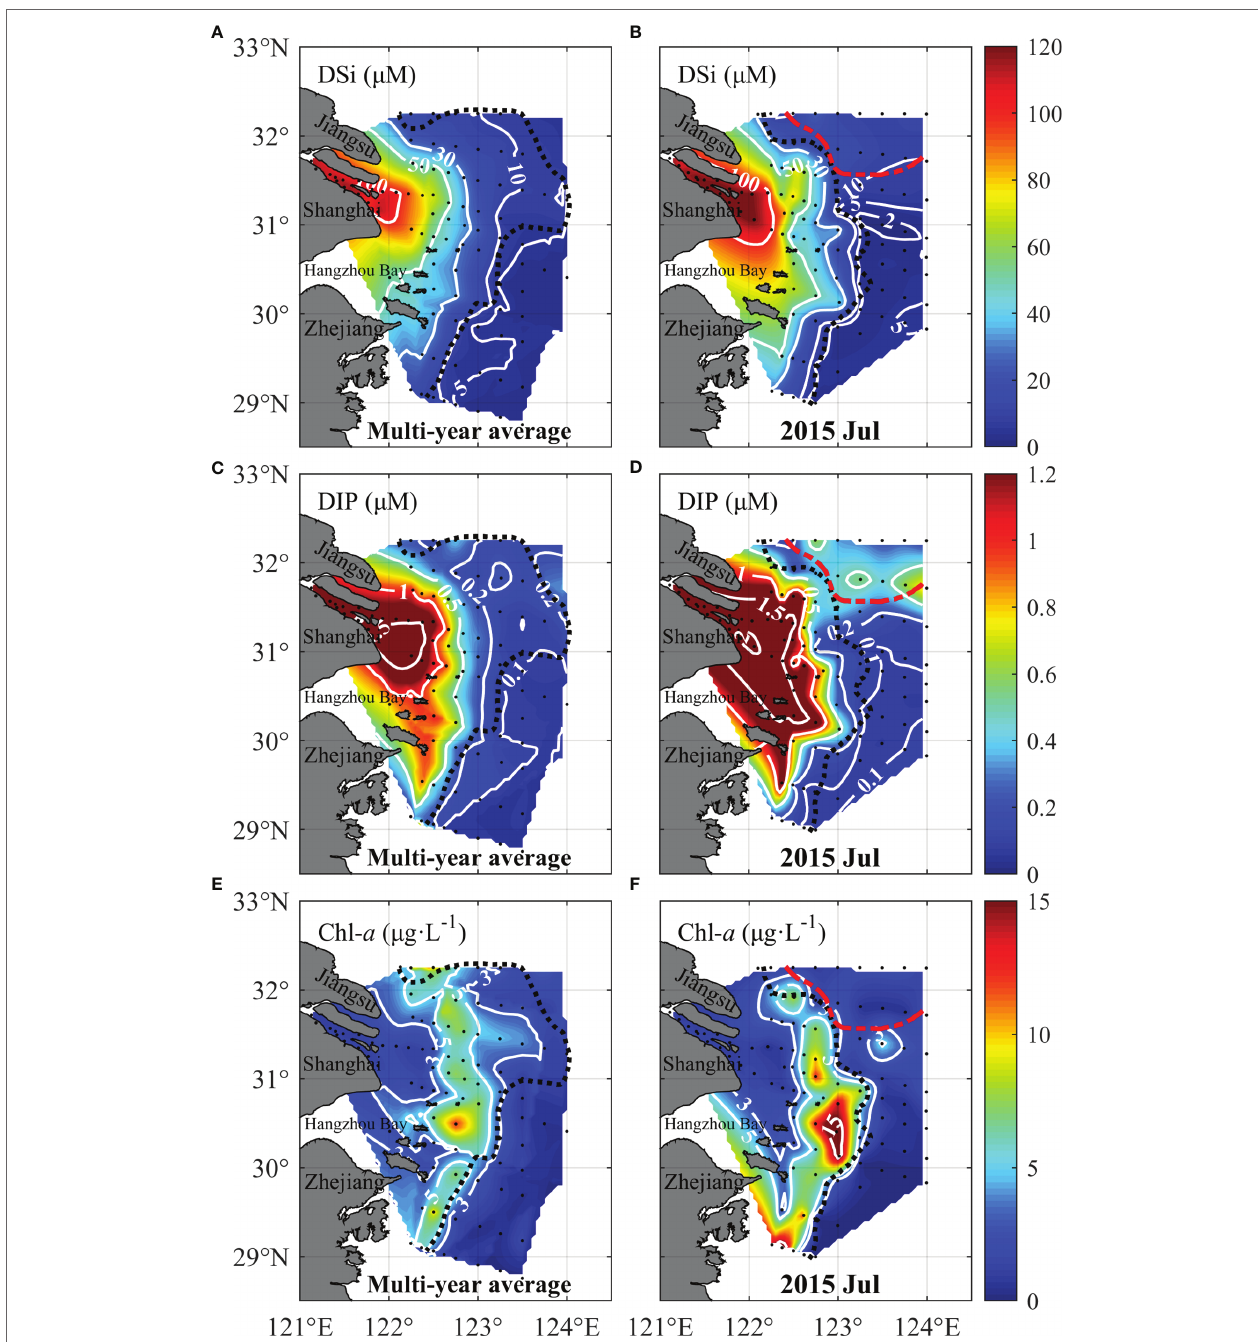
FIGURE 10 | Spatial distributions of the dissolved silicate (DSi; A, B ), dissolved inorganic phosphate (DIP; C, D ), and Chl- a concentration (E, F) during the summer of multi-year average (2013–2018, A, C, E ), and 2015 (B, D, F) . The black line represents the plume front. The red line indicates the boundary of the